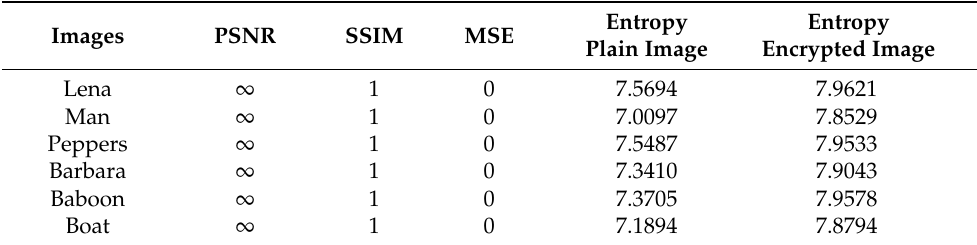
Table 1. PSNR, SSIM, MSE, and Entropy values for the input test